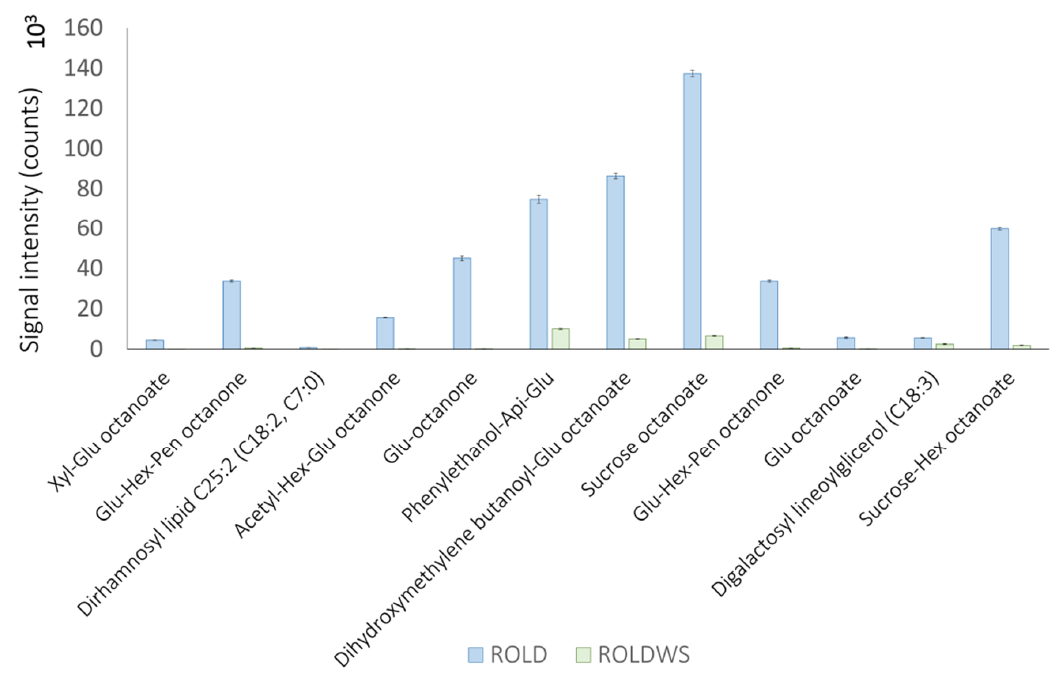
Figure 7. Glycolipids varying in RolDWS samples. Error bars indicate standard deviation and 10 X specifies the unit of visualization.